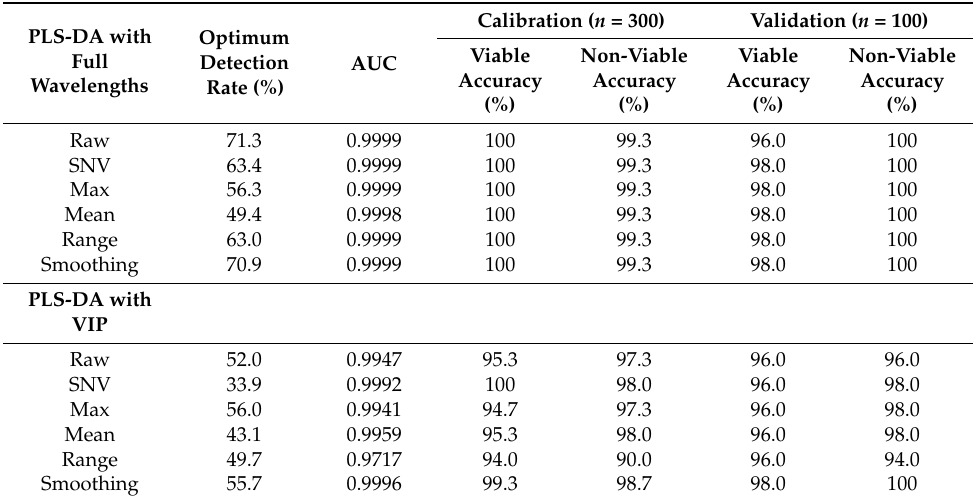
Table 4. Classification results for seed image using Optimum detection rates for each pretreatment method.